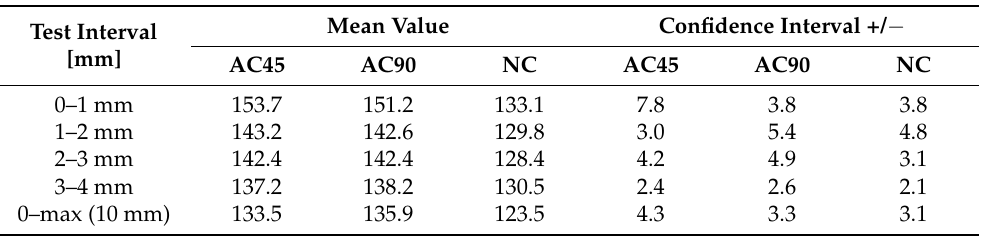
Table 6. Mean values of hardness as a function of distance from the surface and ranges of variability of the tested